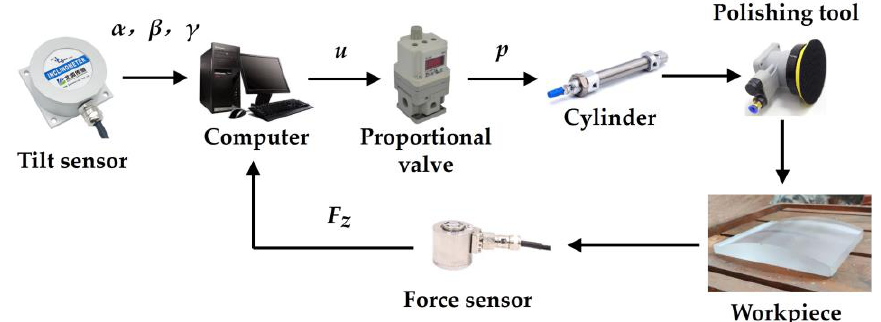
Figure 7. Principle diagram of force-controlled actuator control system.